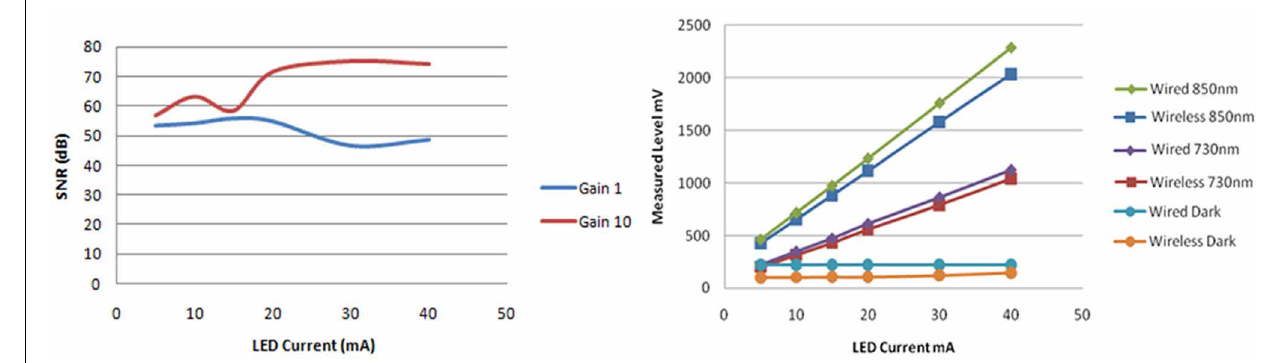
FIGURE 14 | Signal to noise ratio of one of the inputs for different LED currents and input gain settings (left). Comparison of wired and wireless system light intensity measurements